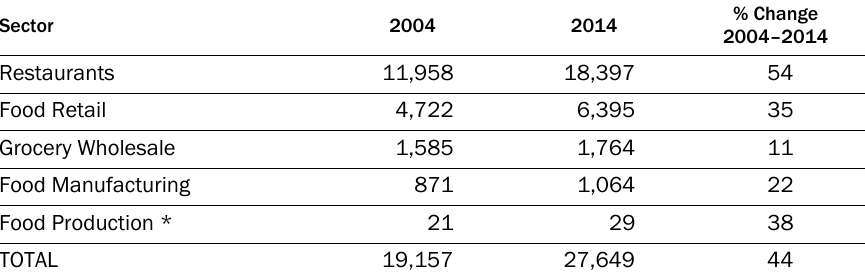
Table 2. Changes in Numbers of Establishments in New York City’s Food Sector, 2004–2014